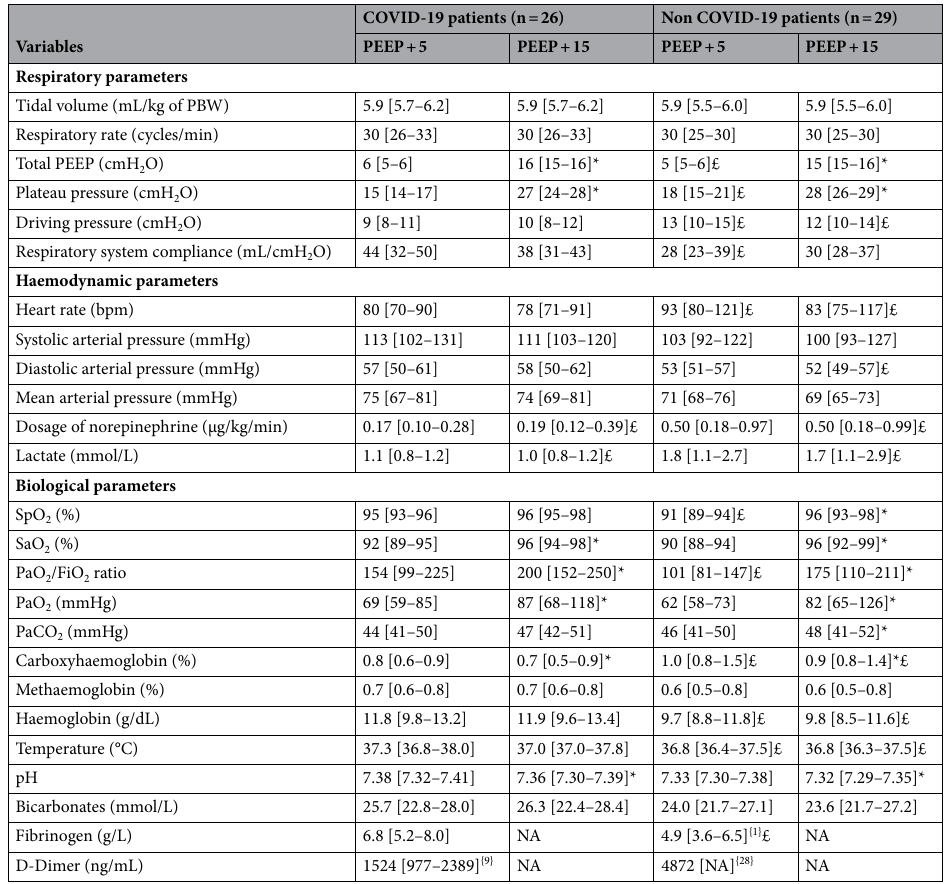
Table 2. Respiratory, haemodynamic and oxygenation effects of the PEEP trial according to patients’ COVID-19 status. Variables are expressed as median [interquartile]. No missing values, except otherwise specified between {}. NA: non-available. PaO 2 partial arterial pressure of oxygen, PaCO 2 partial arterial pressure of carbon dioxide; PBW: predicted body weight, PEEP positive end-expiratory pressure, SaO 2 arterial oxygen saturation, SpO 2 pulse oximetry. * p < 0.05 PEEP + 15 vs. PEEP + 5 cmH2O. £ p < 0.05 non-COVID-19 versus COVID-19 patients. Formulas: driving pressure = plateau pressure-total PEEP; respiratory system compliance = tidal volume/(plateau pressure-total